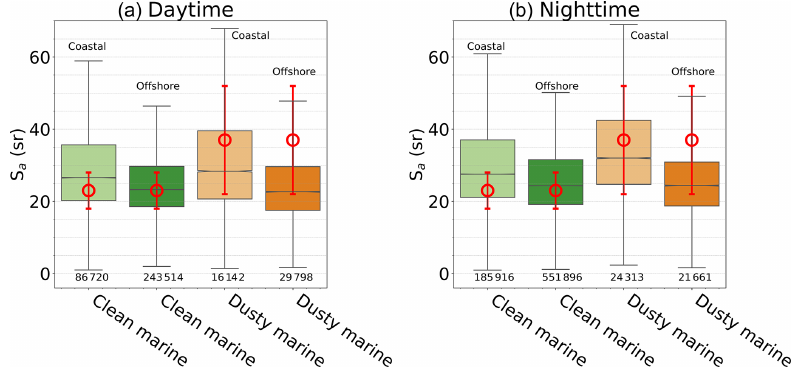
Figure 13. Lidar ratios for clean marine and dusty marine over oceanic regions within 5 ◦ degree from the coast (coastal) and at least 10 ◦ away from the coast (offshore). Red circles represent the prescribed lidar ratio in V4 and the associated uncertainty (error bar). Panels (a) and (b) correspond to daytime and nighttime retrievals, respectively.